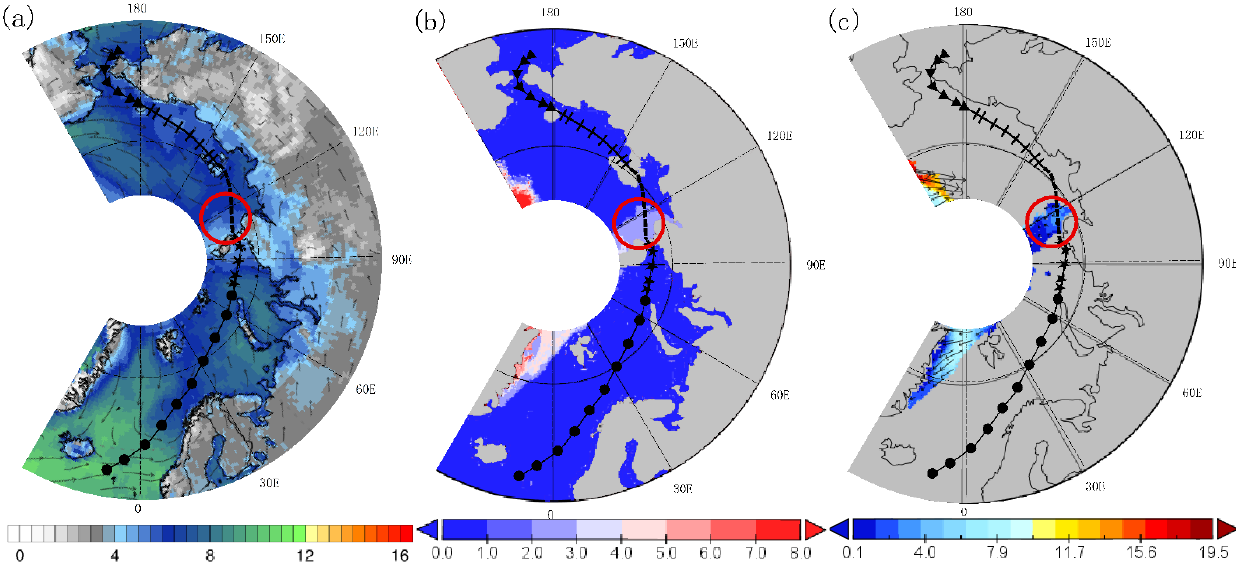
Figure 16. The average wind field ( a ), sea ice age ( b ) and sea ice movement ( c ) of the NEP in the Arctic in September 2007.